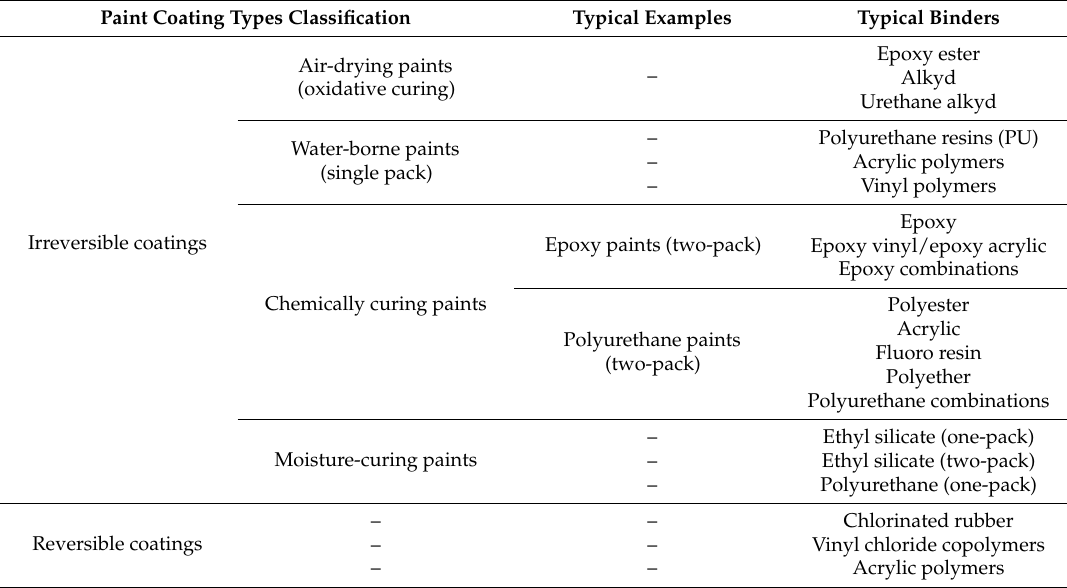
Table 5. Classification of paint coating types according to EN ISO 12944-5:2007